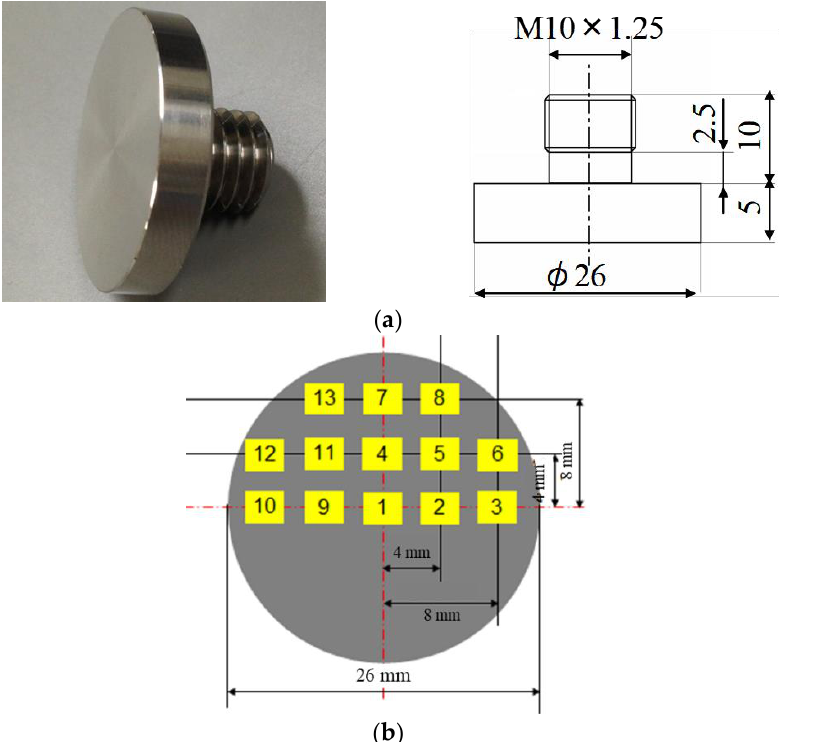
Figure 2. Experimental specimen. ( a ) Appearance and dimensions of specimen, ( b ) Observed point of specimen